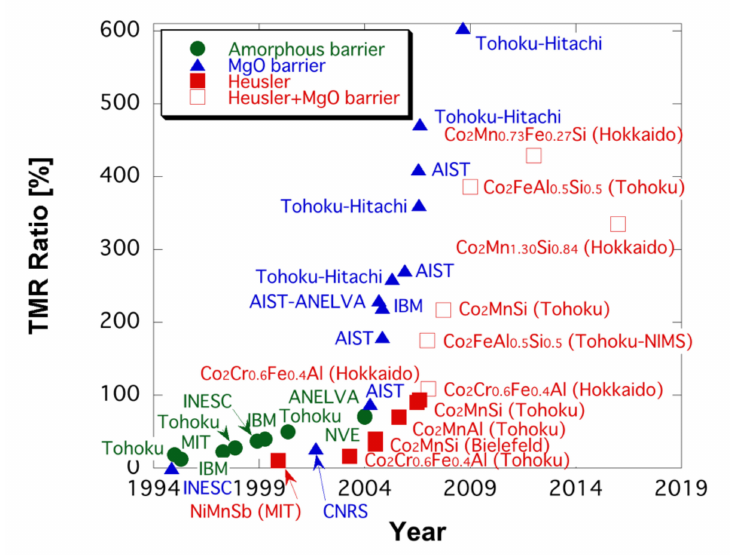
Figure 1. Evolution of TMR ratios at room temperature